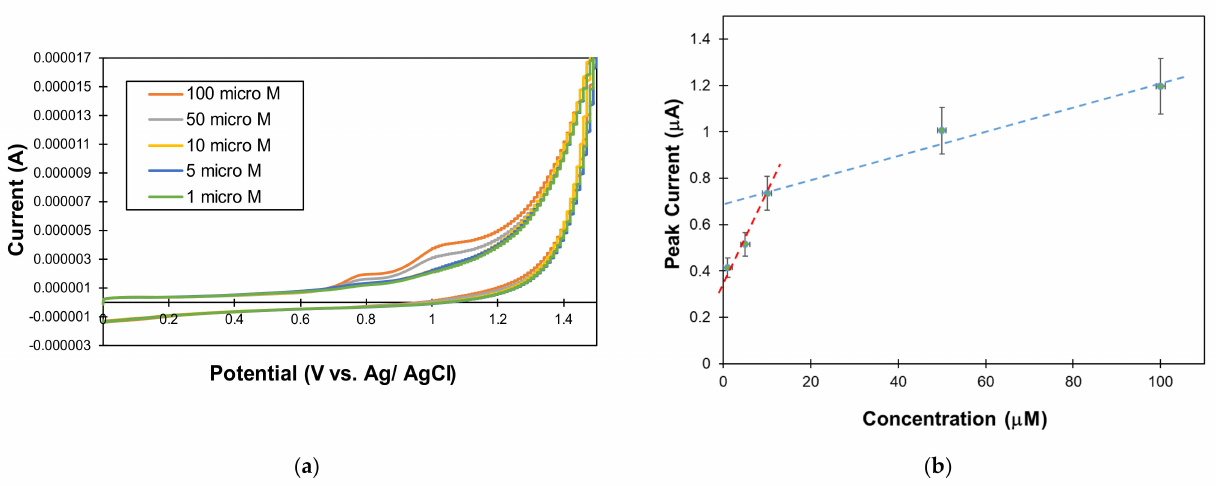
Figure 5. ( a ) Cyclic voltammograms and ( b ) Calibration curve of SFX solutions using GCE electrode in phosphate buffer solution, pH = 7.00 at 50 mV · s − 1 . Experimental conditions: counter electrode: Pt, reference electrode: Ag/AgCl; room temperature; stagnant